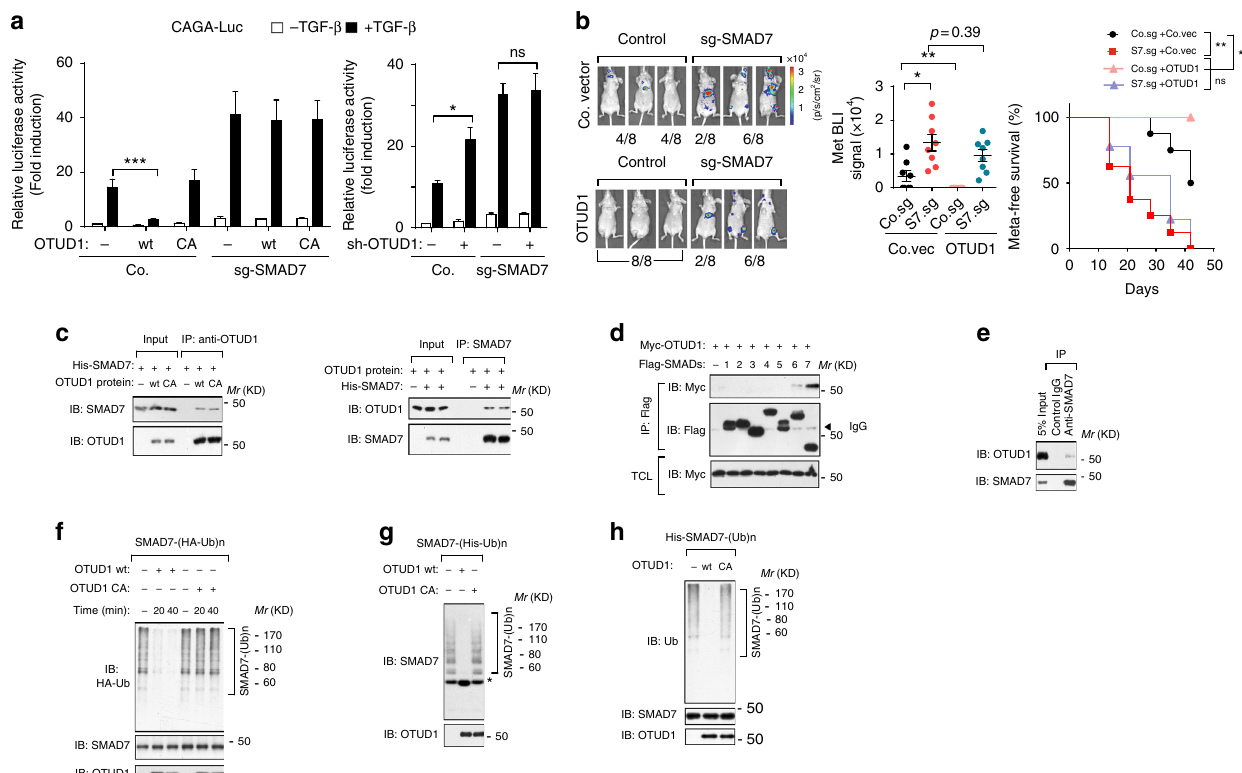
Fig. 4 OTUD1 interacts with and deubiquitinates SMAD7 in vitro. a Effect of OTUD1-wt and CA mutant (left panel) or sh-OTUD1 #1 (right panel) on CAGA 12 -Luc transcriptional response induced by TGF- β (2.5 ng/ml) for 16 h in HEK293T cells. Co., control sgRNA. b Left panel: BLI of three representative mice injected with MDA-MB-231 control cells or cells de fi cient in SMAD7 (sg-SMAD7) that ectopically expressed with control vector (Co.vec) or OTUD1, images were taken 6 weeks after injection. Middle panel: BLI signals of all mice in each experimental group at week 6. Right panel: the percentage of metastasis-free mice in each experimental group followed in time. c Puri fi ed SMAD7 and OTUD1-wt/CA interaction in vitro. Prokaryotic puri fi ed SMAD7 and eukaryotic puri fi ed OTUD1 proteins were incubated and immunoprecipitated with anti-OTUD1 (left panel) or with anti-SMAD7 (right panel) antibodies. Immunoprecipitates were then immunoblotted for OTUD1 and SMAD7. d IB analysis of total cell lysate (TCL) and immunoprecipitates derived from HEK293T cells transfected with Myc-OTUD1 and Flag-SMAD1-7 constructs as indicated. e IB of anti-SMAD7 immunoprecipitate derived from HEK293T cells. Association between OTUD1 and SMAD7 was examined. 5% total cell lysates was loaded as input. f – h OTUD1 deubiquitinates poly- ubiquitination of SMAD7 in vitro. Flag-SMAD7 and HA-Ub were transfected in HEK293T cells. Poly-ubiquitinated SMAD7 was then immunoprecipitated with anti-Flag M2 beads and incubated with puri fi ed OTUD1-wt/CA protein as indicated time. Lysates were analyzed by IB with anti-HA-Ub, anti-SMAD7, and anti-OTUD1 antibodies f . Flag-SMAD7 and His-Ub were transfected into HEK293T cells. Subsequently, poly-ubiquitinated SMAD7 from the cell lysate was pulled down by Nickle beads and incubated with puri fi ed OTUD1-wt/CA for 60 mins. Lysates were analyzed by IB with anti-SMAD7 and anti-OTUD1 antibodies, asterisk indicates free SMAD7 g . His-SMAD7 was fi rst incubated with E1, E2 (UbcH6), GST-RNF12, and ubiquitin in vitro for 3 h at 37 °C. The poly-ubiquitinated His-SMAD7 was immunoprecipitated by anti-SMAD7 antibody then incubated with puri fi ed OTUD1-wt/CA for 60 mins. The assay mixtures were analyzed by anti-Ub, anti-SMAD7 and anti-OTUD1 antibodies ( h ). * p < 0.05, ** p < 0.01, and *** p < 0.001 (two-tailed Student ′ s t -test a , b or two-way analysis of variance (ANOVA) b